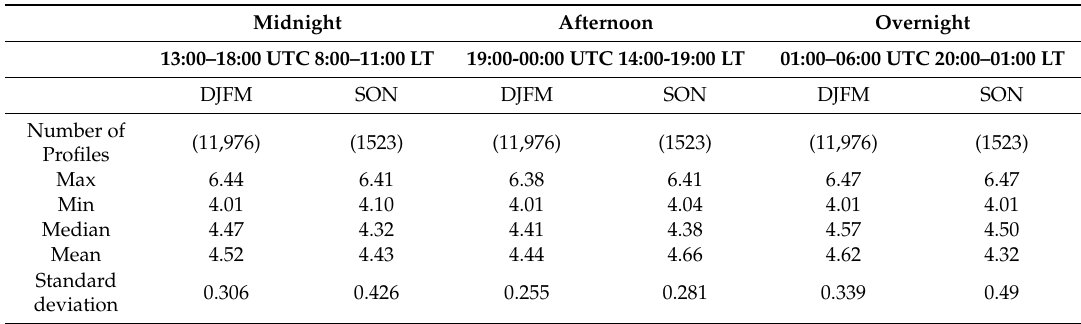
Table 3. Provides detailed information of the bright band height within the di ff erent diurnal times.